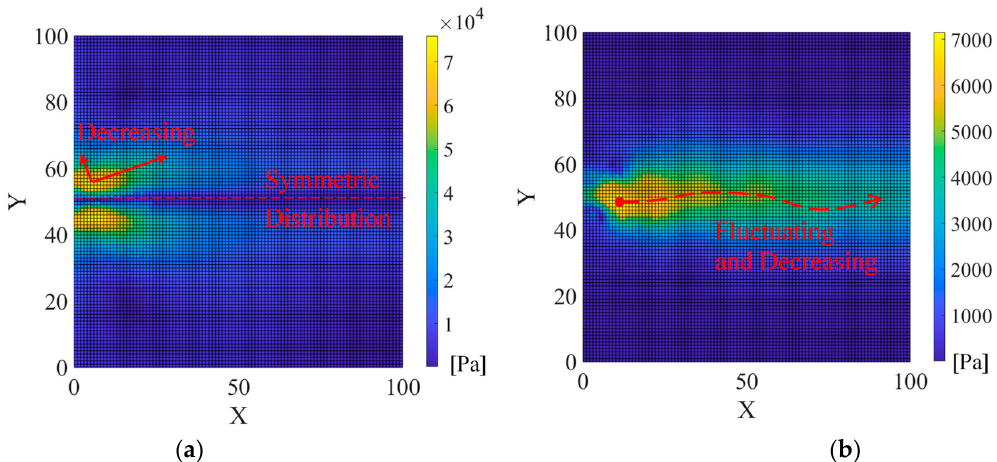
Figure 12. The distribution characteristics of the pulsation amplitude. ( a ) RMS amplitude distribution of f vs . ( b ) RMS amplitude distribution of 2 f vs .